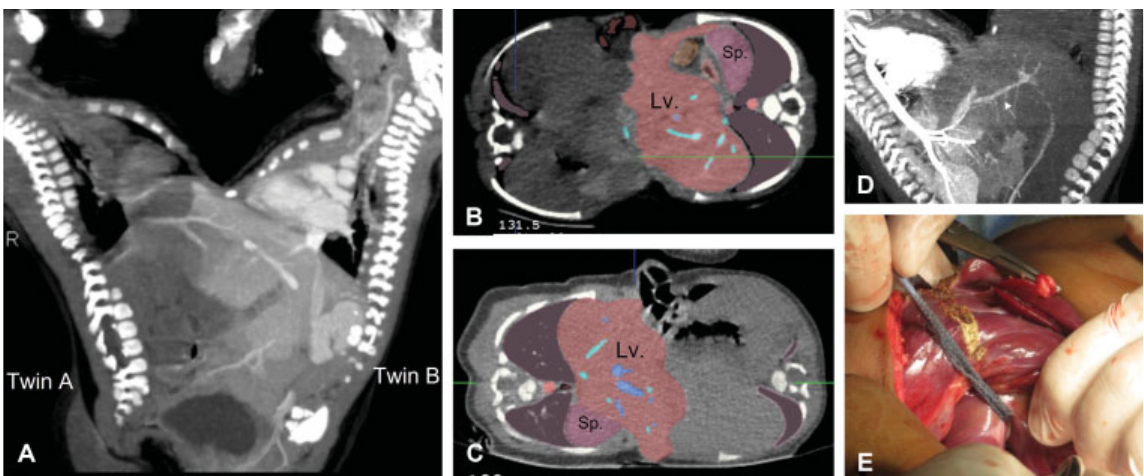
Fig. 2 Demonstration of hepatic fusion in omphaloischiopagus conjoined twins. ( A ) CT scan with intra-venous contrast injection into the left twin (twin B). ( B, C ) CTwith color coded display of the contrast enhanced liver to demonstrate the plan of cleavage between both twins (Visible Patient). ( D ) CT scan with intravenous contrast injection into the right twin (twin A); note the presence of a sizable hepatic vein (white arrow) traversing the plane of cleavage between both twins. ( E ) Creation of plan of cleavage at operation. CT, computed tomography; Lv, liver; Sp, spleen.